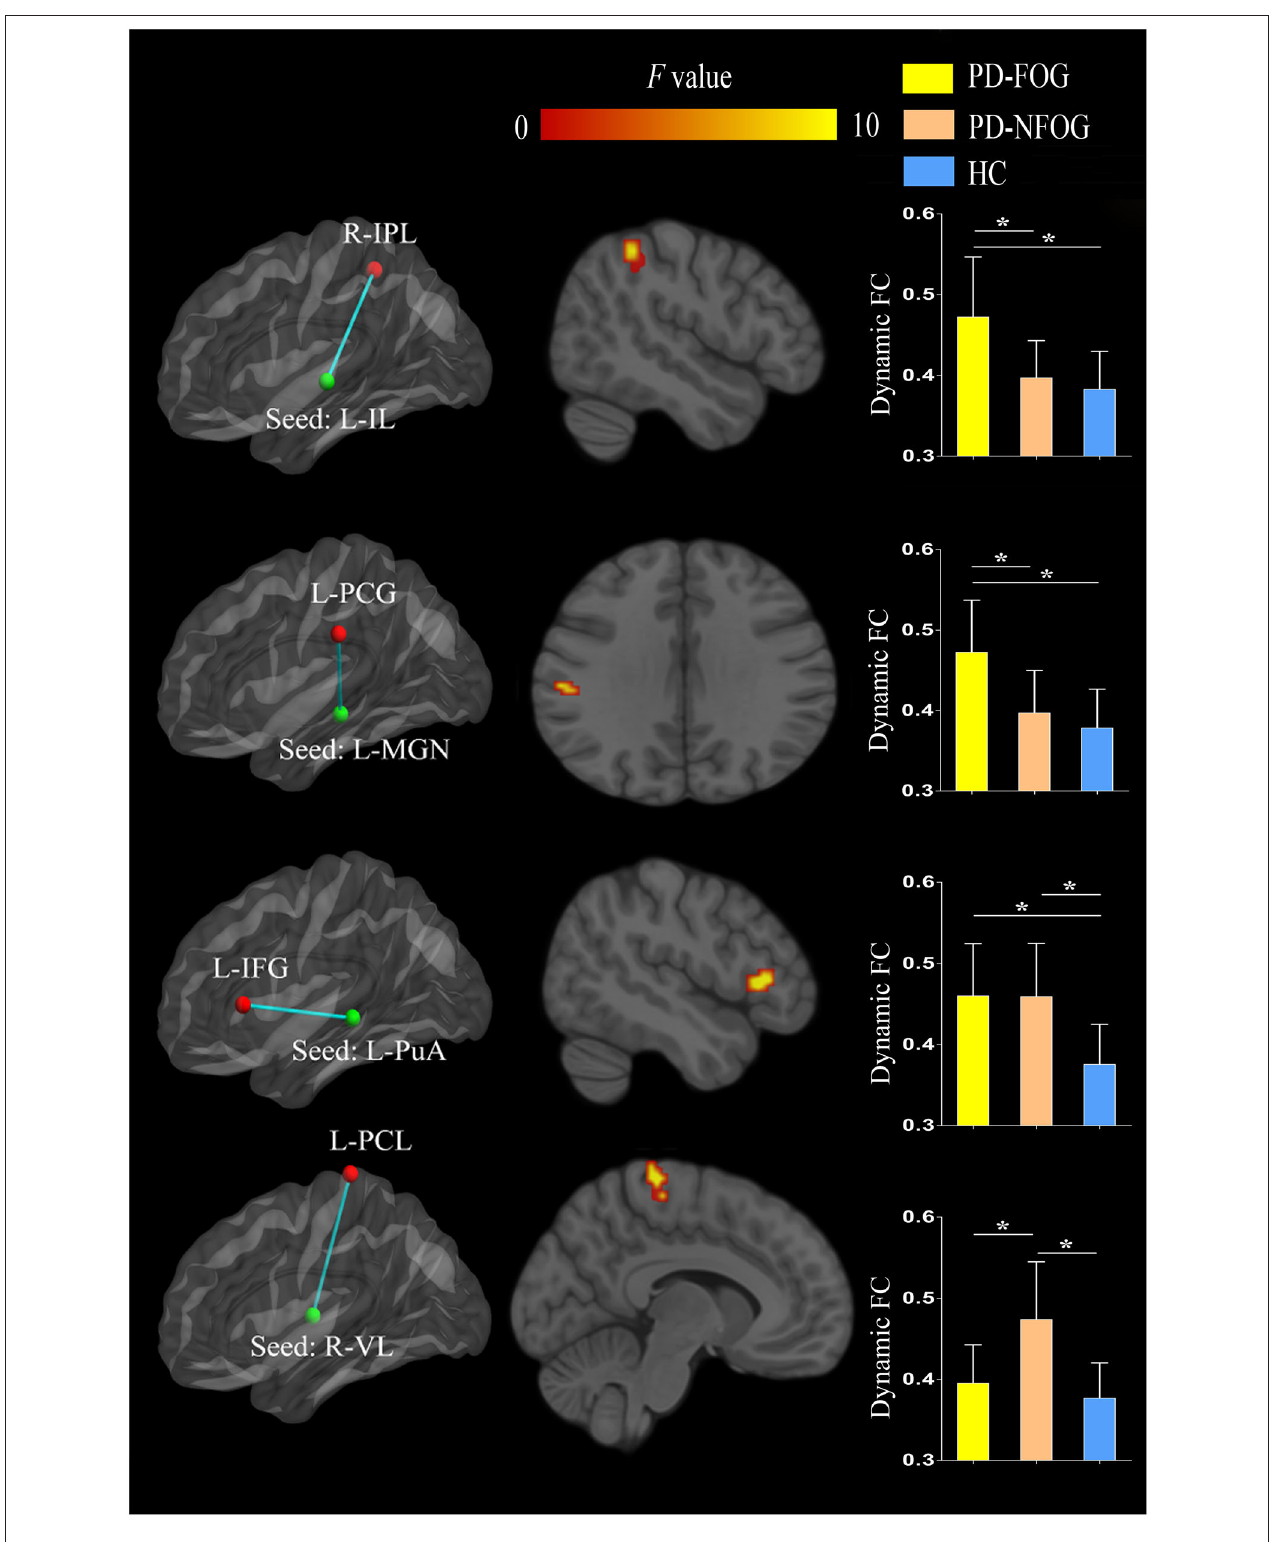
FIGURE 3 | Inter-group differences in dynamic FC of the thalamic nuclei between PD-FOG, PD-NFOG, and HC. FC, functional connectivity; HC, healthy controls; IFG, inferior frontal gyrus; IL, intralaminar nuclei; IPL, inferior parietal lobule; L, left; MGN, medial geniculate nuclei; PCG, postcentral gyrus; PCL, paracentral lobule; PuA, pulvinar anterior nuclei; PD-FOG, Parkinson’s disease patients with freezing of gait; PD-NFOG, Parkinson’s disease patients without freezing of gait; R, right; VL, ventral lateral nuclei; * p < 0.001.